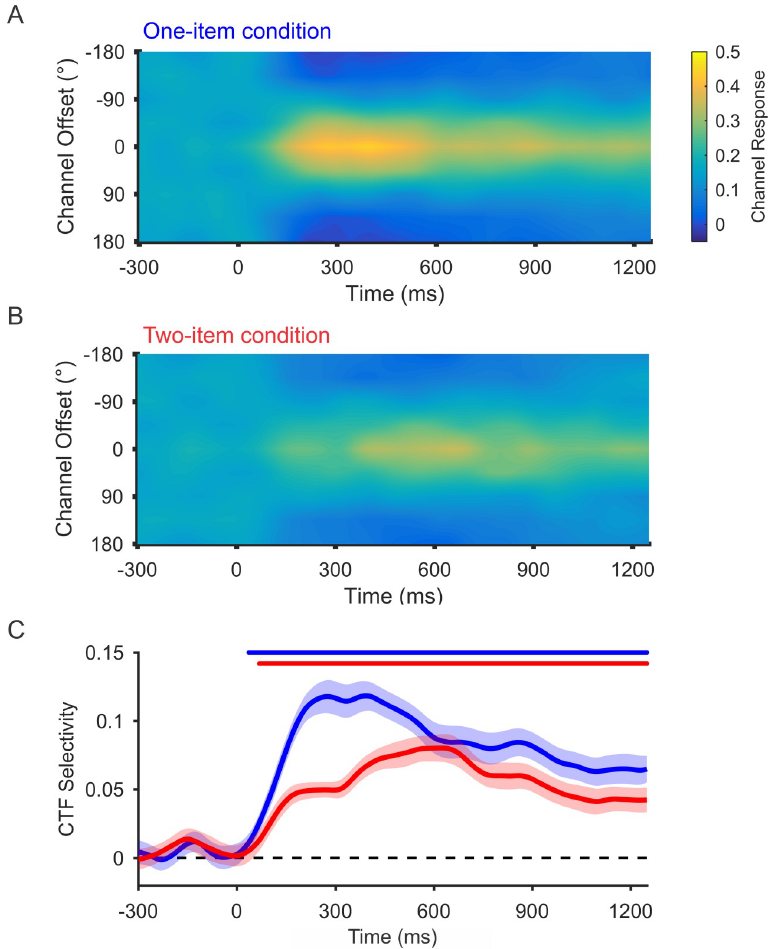
Fig 3. Spatial alpha-band CTFs as a function of memory load. Average alpha-band CTF in the one- and two-item conditions (A and B, respectively). (C) The spatial selectivity of alpha-band CTFs across time (measured as CTF slope, see Materials and methods) as a function of memory load. The blue (one-item) and red (two-item) markers at the top of the panel indicate the period of above-chance selectivity obtained using a cluster-based test. CTF selectivity was reliably higher in the one-item condition than in the two-item condition. The shaded error bars reflect ± 1 SEM across observers. Data are available at https://osf.io/47cmn/. CTF, channel-tuning